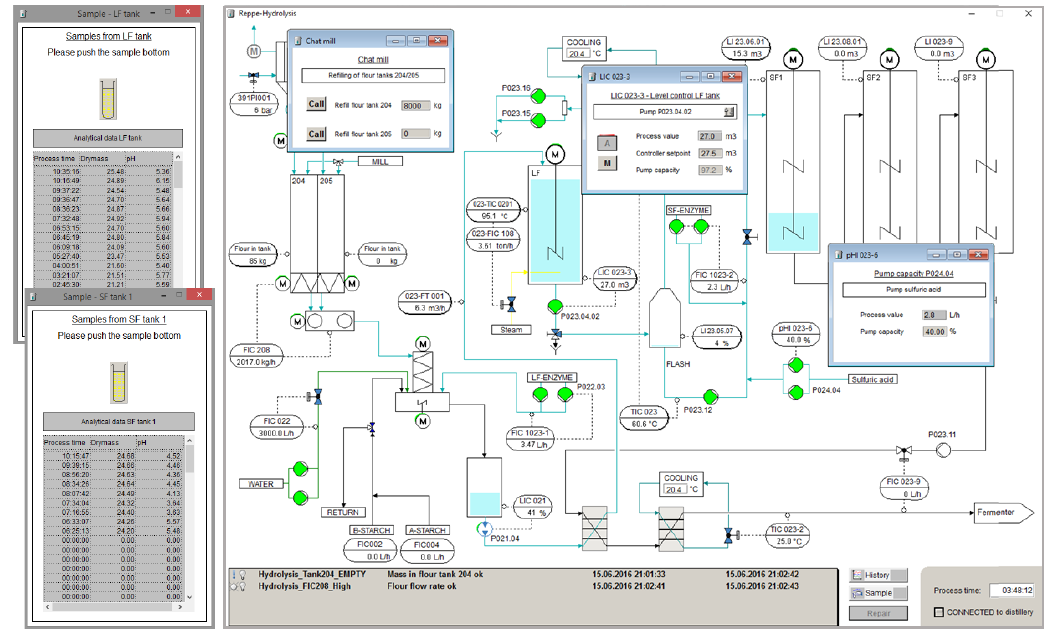
Figure 7. The LF tank was filled and heated to 90 ◦ C. Set point for the level controller was set to 27.5 m 3 and cooling of flash cooler to 60 ◦ C. After starting, the pump P023.12 for the outflow of flash to SF1 tank, feeding of SF-enzyme and acid were started and control set points adjusted. In the chart the trainee adjusted flour mass flow and water flow rate in order to reach a dry mass between 24% and 25% ( w / w ). By pushing the button “ Sample, ” samples can be taken from the LF and SF tanks. pH of SF1 tank was adjusted manually by changing the acid flow rate. Filled volume in tanks are highlighted in light blue. Two alarm messages are shown in the grey box below informing about the flour tank volume. This tank was refilled by the trainee.